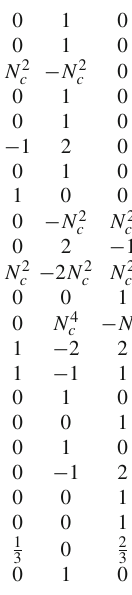
Table 15 The large N c limit of the matrices M from Table